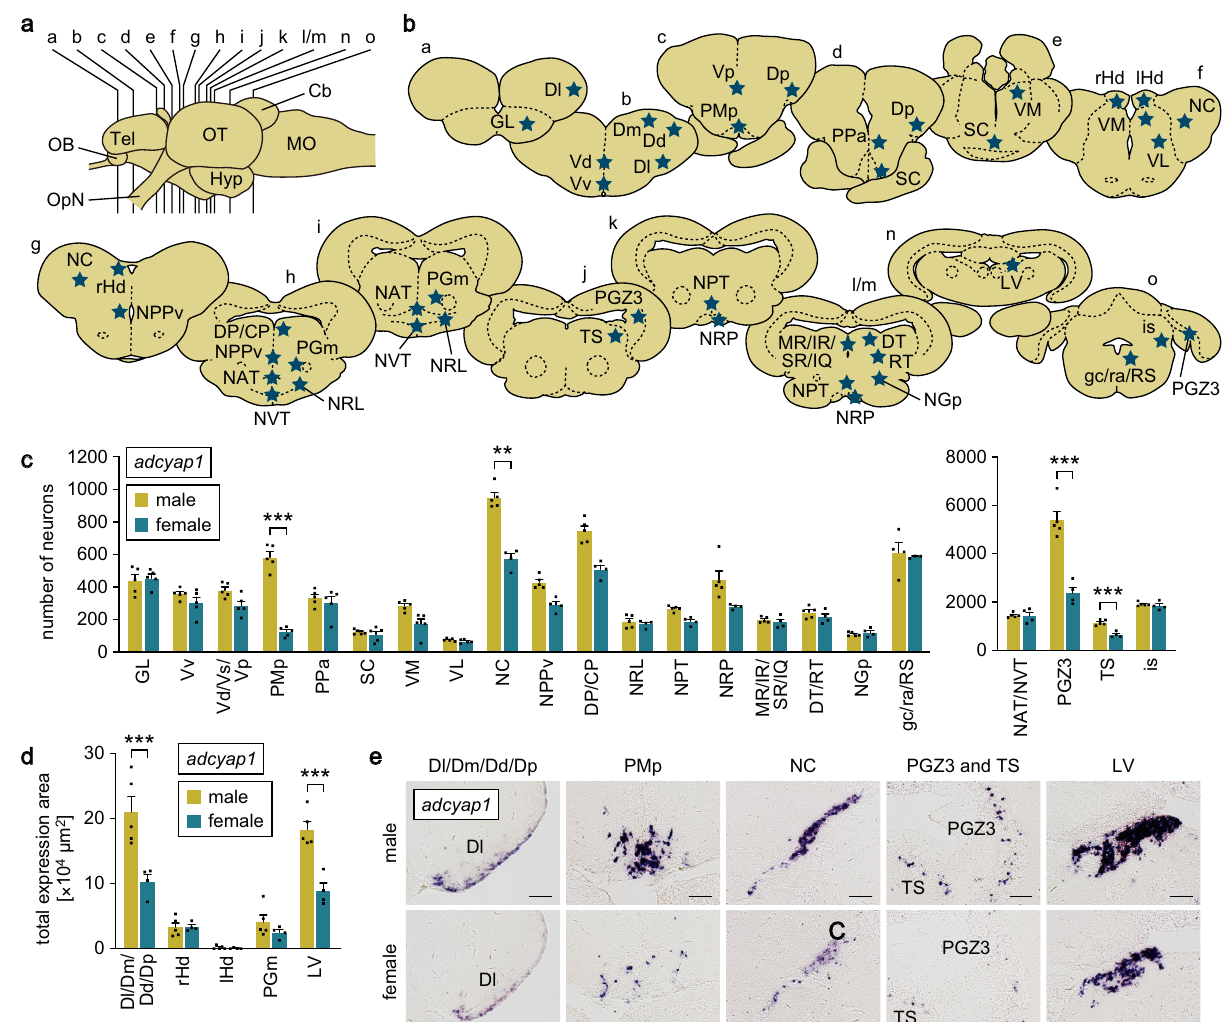
Fig. 2 The POA is the major source of the sex-biased expression of adcyap1 in the brain. a Lateral view (anterior to the left) of the medaka brain showing the approximate levels of sections in panel b . b Line drawings of coronal brain sections showing the location of nuclei containing adcyap1 -expressing neurons (stars). c Number of adcyap1 -expressing neurons in each brain nucleus of males ( n = 5, except for gc/ra/RS, where n = 4) and females ( n = 5 for nuclei from GL to VL; n = 4 for nuclei from NC to is, except for gc/ra/RS, where n = 3). The data are split into two graphs for visual clarity. d Total area of adcyap1 expression signals in Dl/Dm/Dd/Dp, rHd, lHd, PGm, and LV nuclei, where adcyap1 -expressing neurons were tightly clustered, and their exact number could not be determined ( n = 5 and 4 for males and females, respectively). e Representative micrographs showing adcyap1 expression in nuclei where signi fi cant differences between the sexes were detected. Scale bars represent 50 μ m. Quantitative data were expressed as means with error bars representing standard error of the mean. Statistical differences were assessed by unpaired t -test with Bonferroni-Dunn correction ( c , d ). ** p < 0.01; *** p < 0.001. For abbreviations of brain nuclei, see Supplementary Table